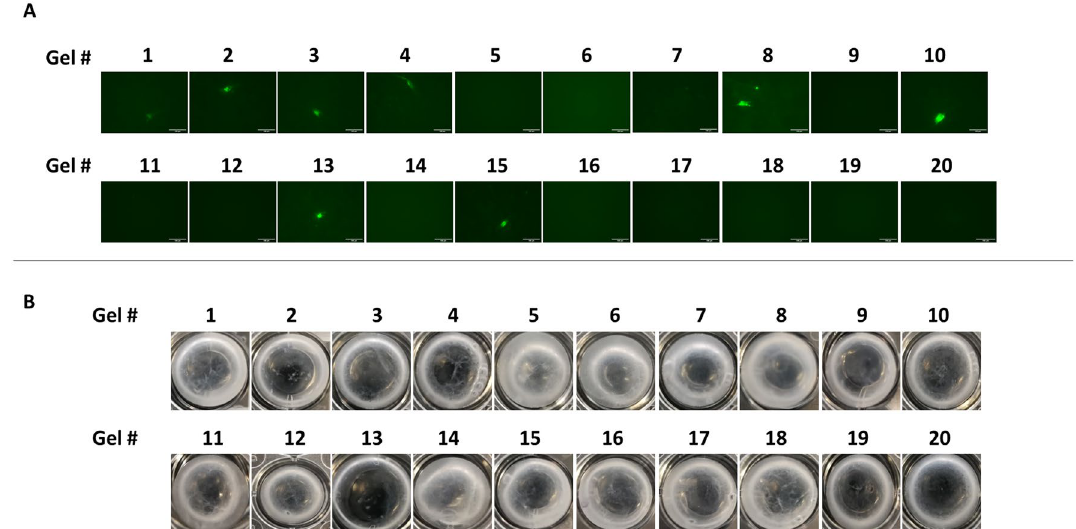
Figure 6. Transfection efficiency and degradation rate of fibrin hydrogels. Healthy fibroblasts were seeded on hydrogels prepared using different concentrations of thrombin, aprotinin and DNA (concentrations are indicated in Table 2). Fluorescence images were taken after two days ( A ), whereas brightfield pictures of the biomaterials were taken after three days ( B ). N = 3.